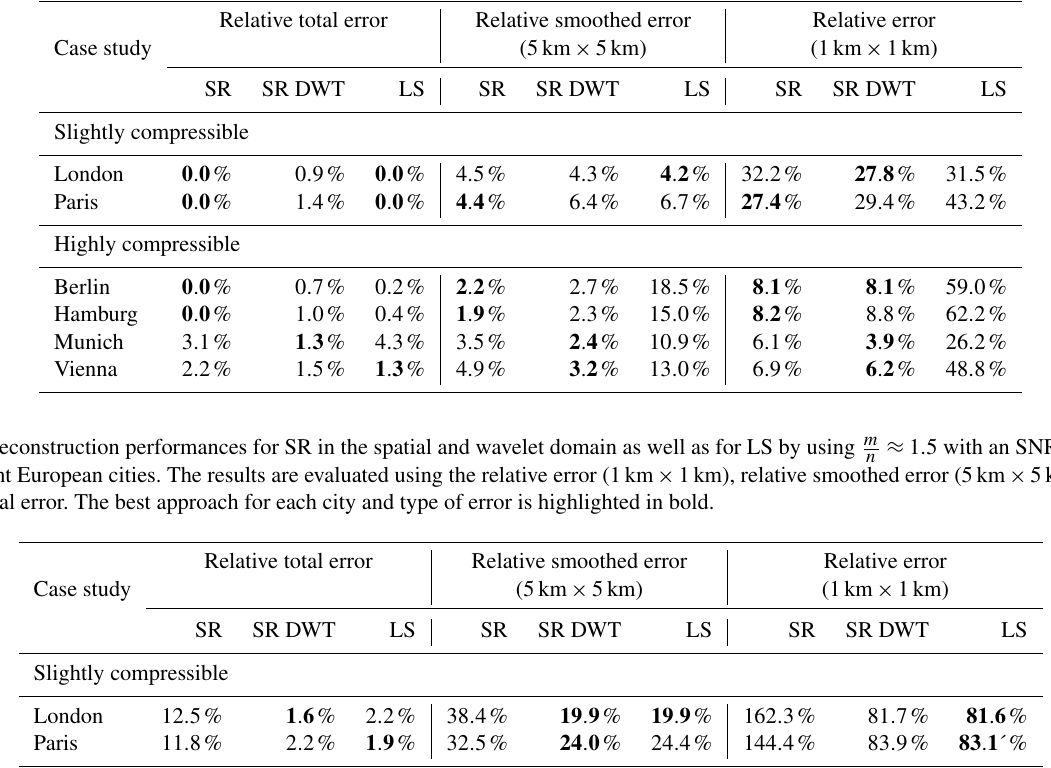
Table 3. Reconstruction performances for SR in the spatial and wavelet domain as well as for LS by measuring the relative error (1km × 1km), relative smoothed error (5km × 5km), and the relative total error for different European cities. The best approach for each city and type of error is highlighted in bold.